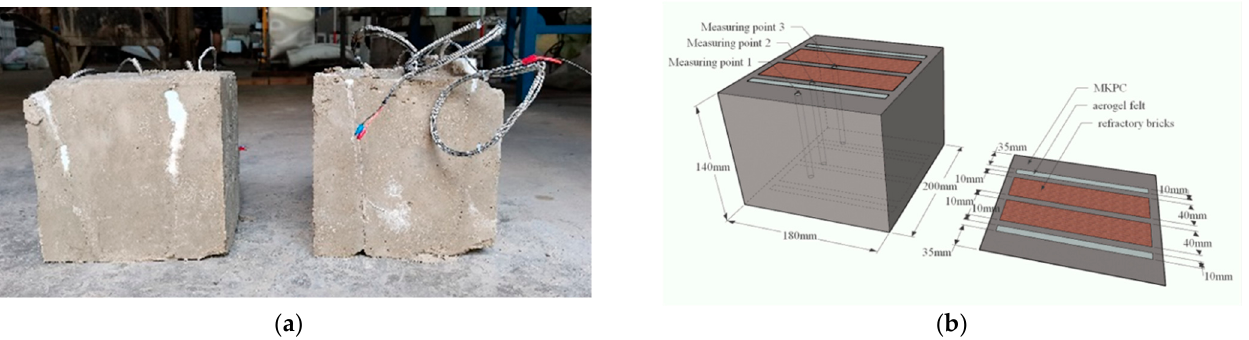
Figure 2. Potassium magnesium phosphate laminate (unit: mm): ( a ) Physical picture, ( b )